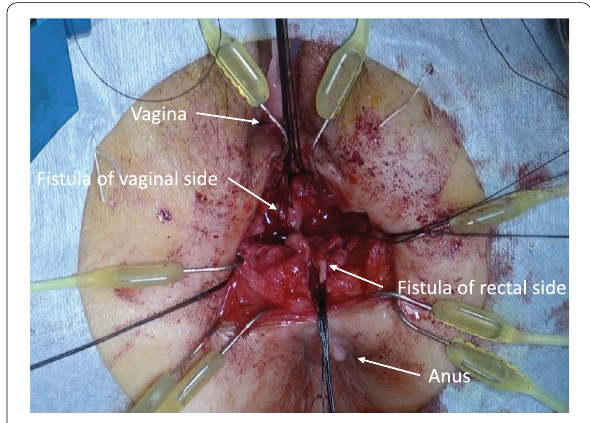
Fig. 3 During the dissection of connective tissues between the rectum and vagina, a rectovaginal fistula was released completely